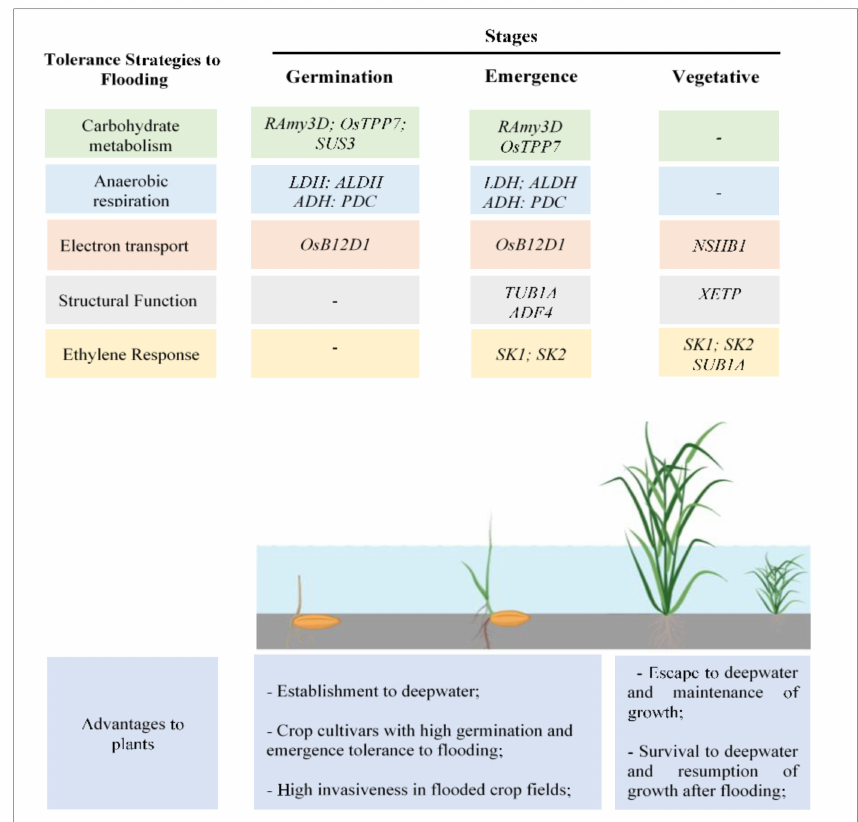
Figure 1. Scheme illustrating the main genes involved in tolerance to flooding at di ff erent plant development stages and potential advantages conferred to